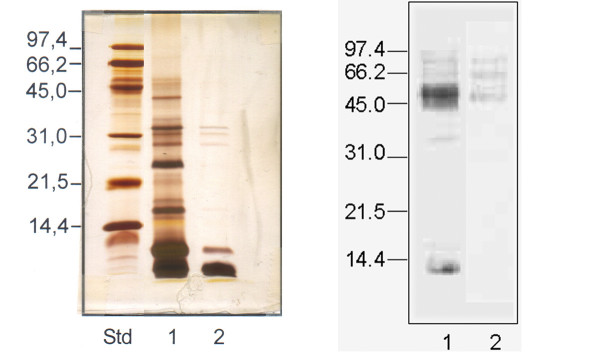
A. SDS-PAGE of the tomato extracts. Lane Std. Standard Low molecular weight (BioRad); Lane 1 Peel extract; lane 2 Pulp extract. B. Immunoblot with a specific pool of sera from tomato sensitized individuals. Solid phase: Lane 1 Peel extract; lane 2 Pulp extract.